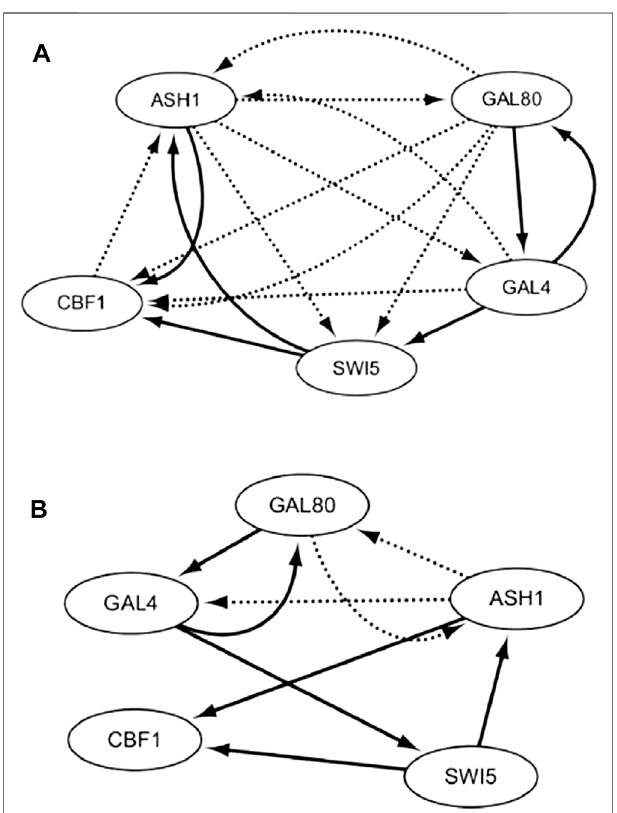
FIGURE 9 | IRMA network by CVTDSS (A) and the IRMA network by TDCC + CVTDSS (B) with the off dataset.